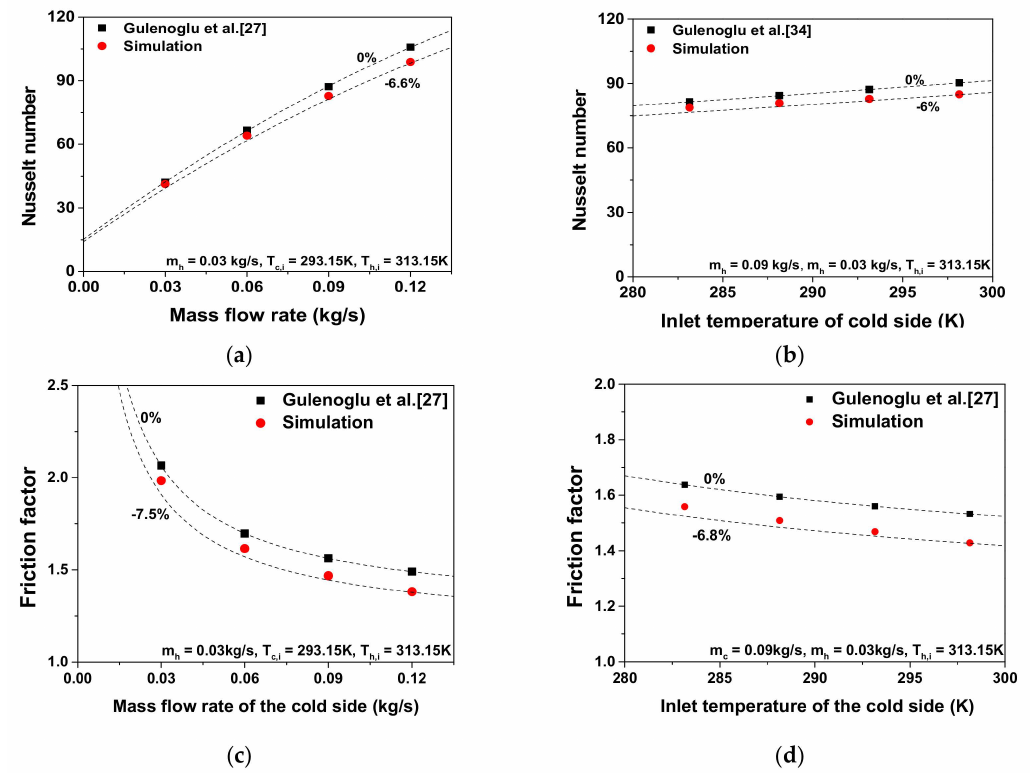
Figure 3. Comparison of Nusselt number according to mass flow rate and temperature: ( a ) Nusselt number according to the mass flow rate; ( b ) the Nusselt number according to the inlet temperature of the cold side; ( c ) friction factor according to the mass flow rate; ( d ) friction factor according to the inlet